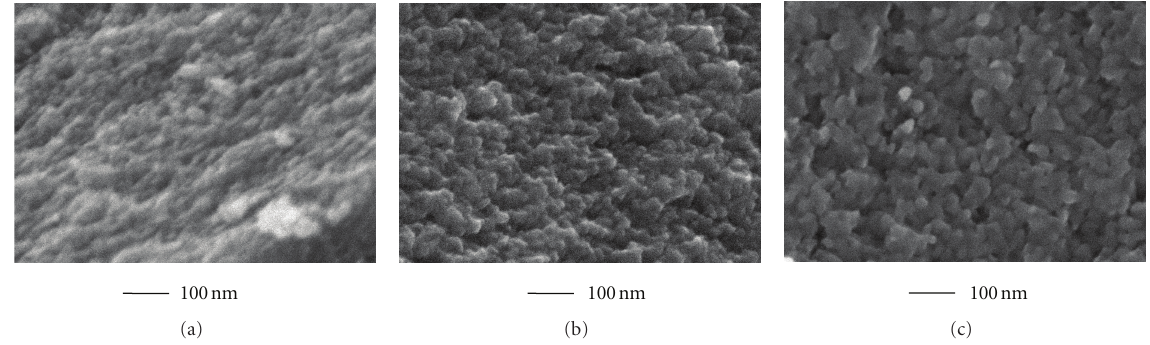
Figure 2: FE-SEM images of the titanium oxide particles obtained by heating the mixture of ethylene glycol solution of TIP and NH 3 (aq) at 368 K for 24 h. The [NH 3 ] values were (a) 0.1 mol/L, (b) 0.5 mol/L, and (c) 1mol/L.